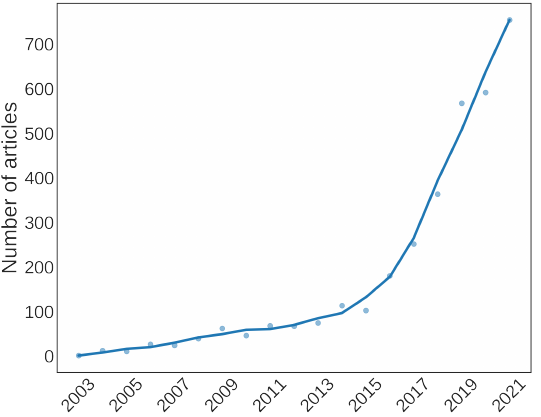
Figure 4. Number of articles retrieved for each